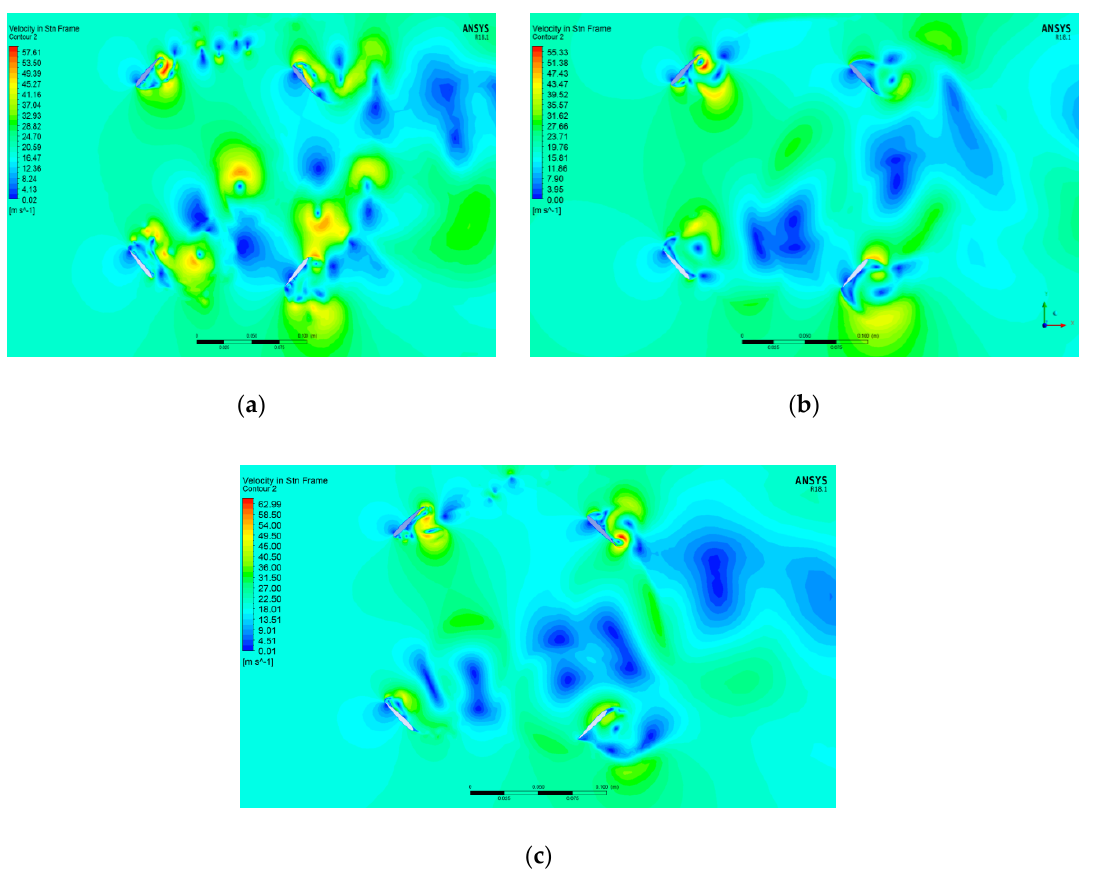
Figure 11. Contours of velocity magnitude for DDES ( a ), RANS Transition ( b ) and RANS SST k-ω ( c ) at 45° azimuthal position at λ max = 0.29.